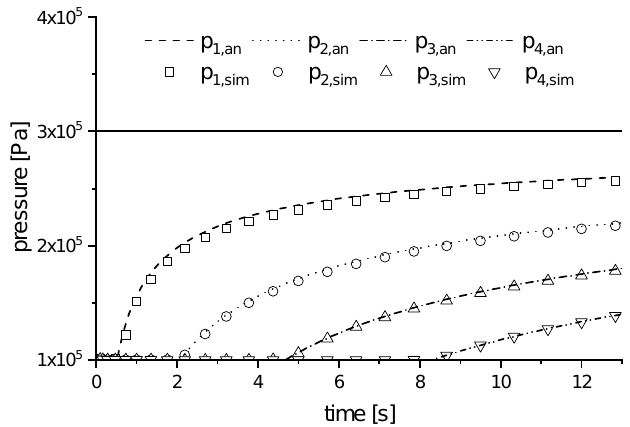
Figure 6. Pressure increase for a constant inlet pressure of 3 × 10 5 Pa. The analytic solutions are compared to the numerical solution using OpenFOAM at four different locations.